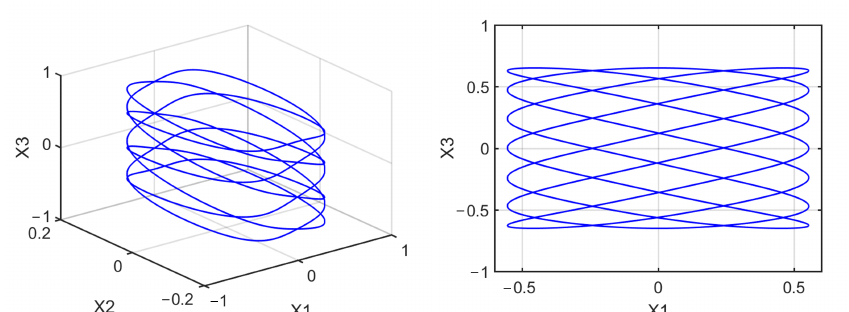
Figure A15. Periodic-7 motion of σ 1 = 5.6284.